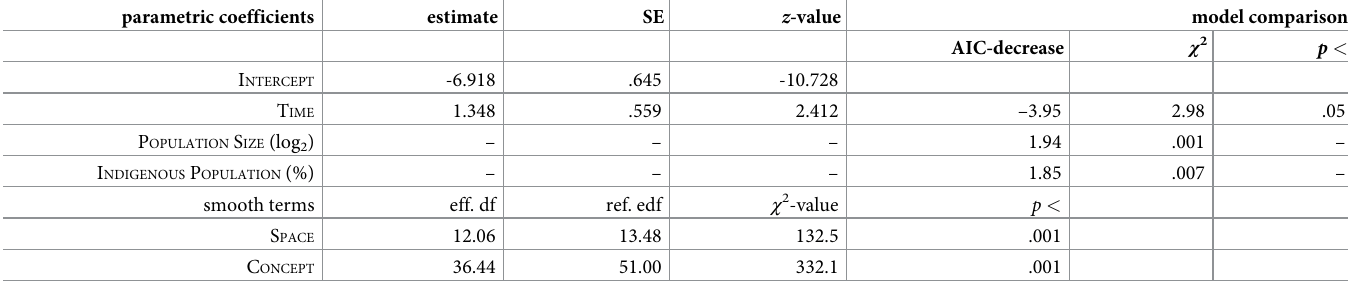
Table 4. Generalized additive mixed-effects model of maximal fit on the occurrence of Spanish variants ( n = 6,475). parametric